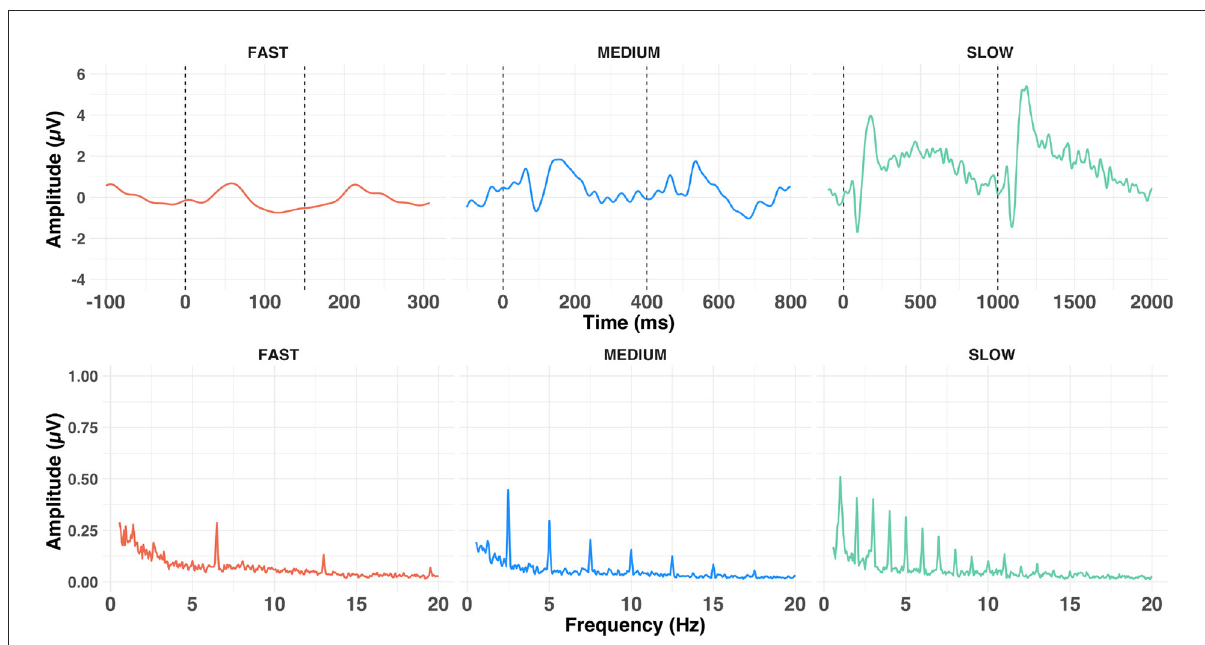
FIGURE4 Average time- (upper row) and frequency- (lower row) domain representation of the grand average waveforms (at Cz) of the cortical response to a-ACC stimuli aggregated across conditions, presented at fast (left), medium (middle) and slow (right) alternating